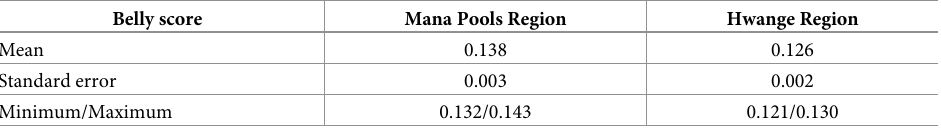
Table 4. Summary statistics of Lycaon pictus belly score means in Hwange and Mana Pool regions, Zimbabwe from suitable photographs obtained from